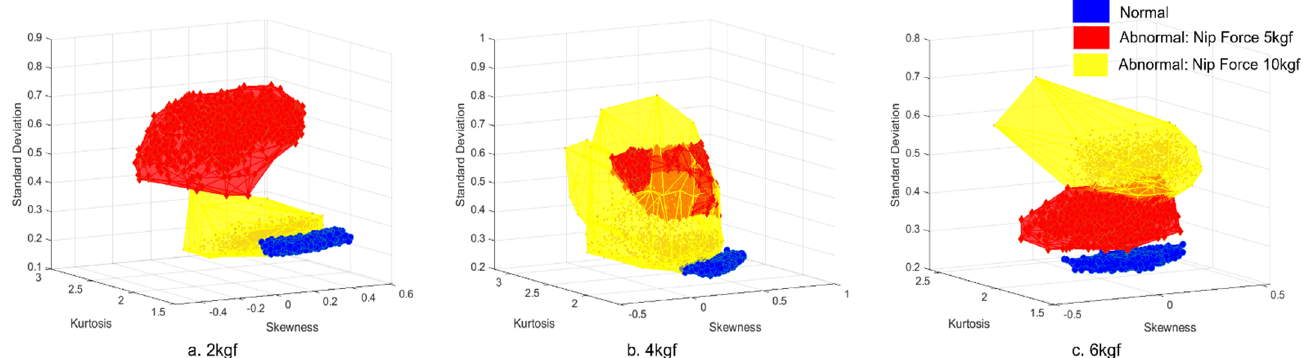
Figure 8. Volume comparison of normal and abnormal condition data: ( a ) Operating tension of 2 kgf; ( b ) Operating tension of 4 kgf; and ( c ) Operating tension of 6 kgf. Table 15. Nip roll eccentricity fault diagnosis based on smart data.